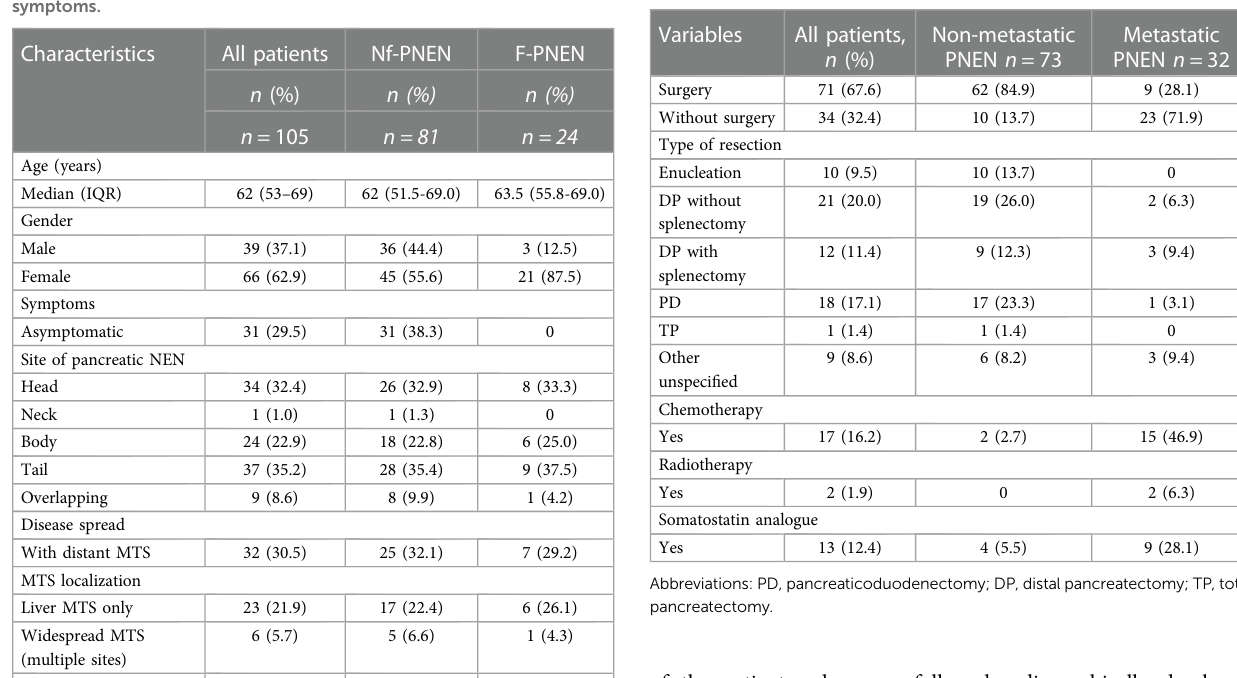
TABLE 2 Treatment modalities for the PNEN